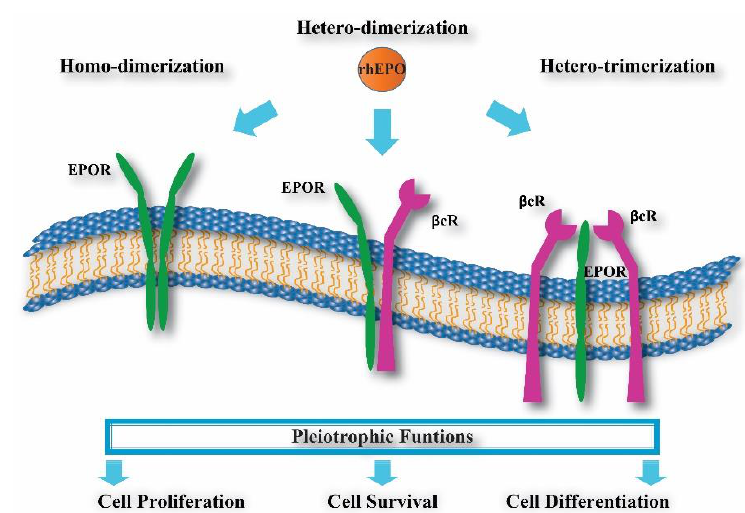
Figure 2. EPO receptors. The rhEPO has been proposed to interact with three possible receptor complexes in initiating its pleiotrophic effects: two units of EPOR = homodimer (green structure), one EPOR and one β cR units = heterodimer (green and purple structure) or one EPOR plus two β cR units = heterotrimer (green and purple